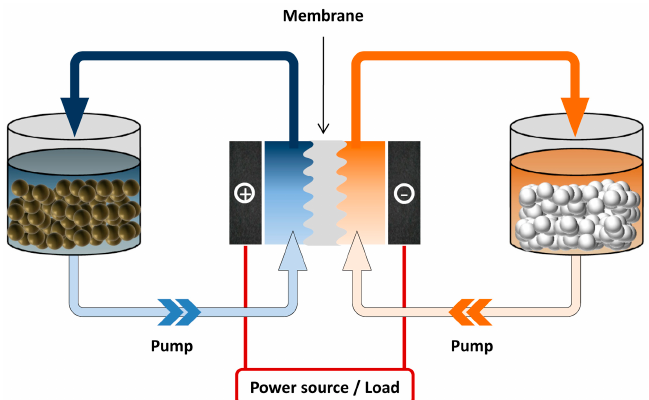
Figure 5. Illustration of a redox flow lithium ion battery. Solid active materials are stored statically in the tanks, while redox molecules are circulated with electrolyte fluids.